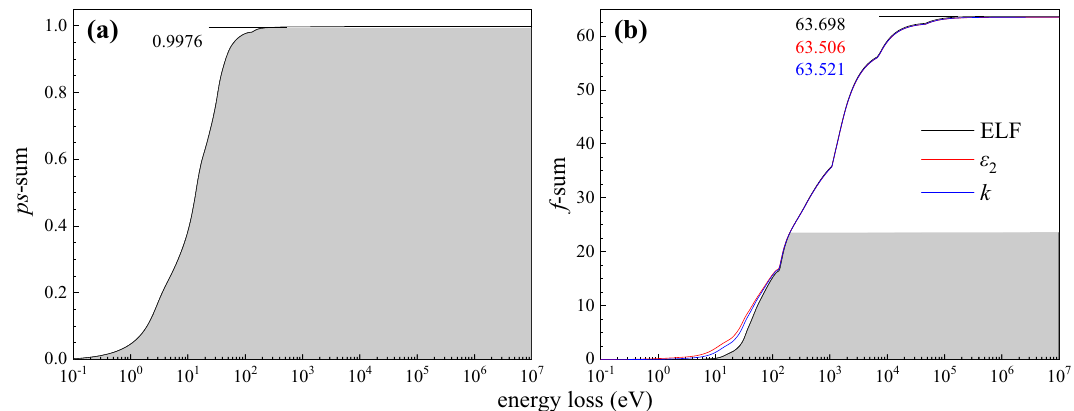
Figure 4. Calculation of ps -sum for ELF ( a ) and f -sum ( b ) rules for ELF (black), ε 2 (red) and k (blue) of Sm obtained from RMC method. Grey area indicates the contribution from the present data (0-200 eV), and the rest part is due to the data of Ref. 22 (200 eV-30 keV) and the data of Ref. 44 (30 keV-10